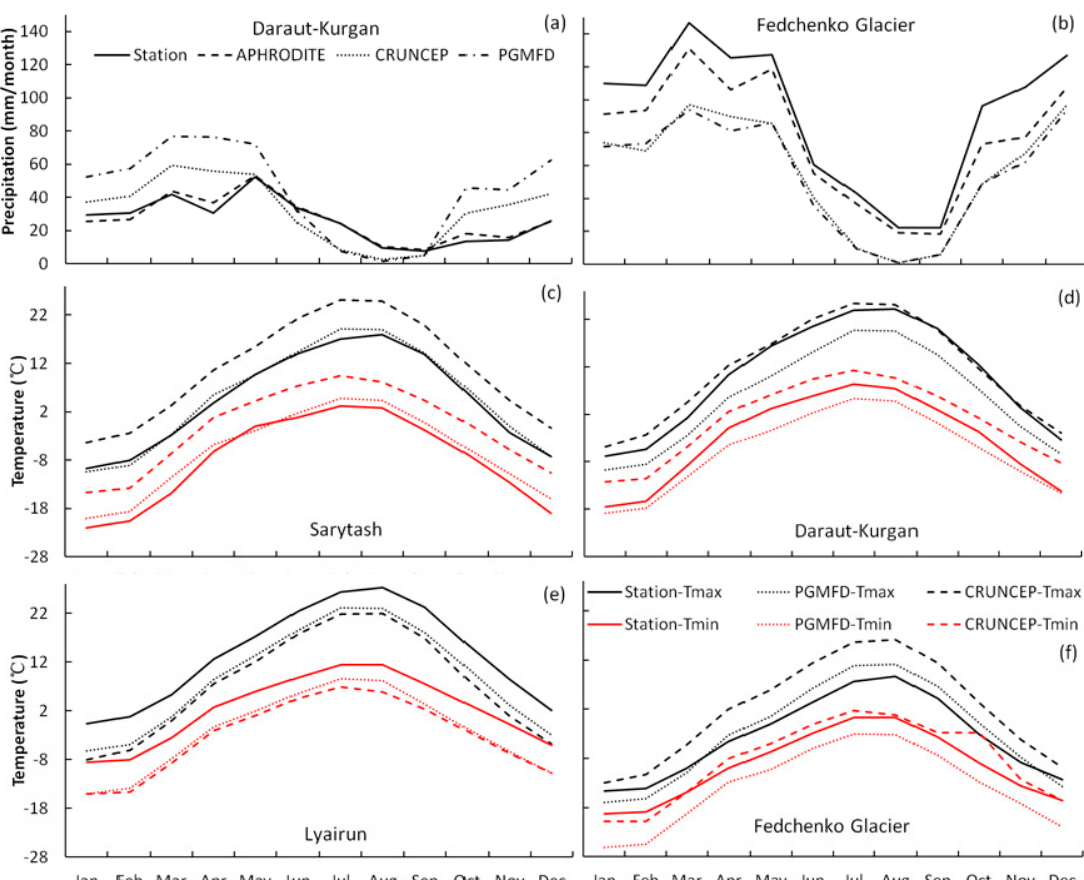
Figure 3. Annual cycles of temperature and precipitation based on the WSD and gridded data sets. ( a ) Annual cycle of precipitation at Daraut ‐ Kurgan station; ( b ) Annual cycle of precipitation at Fedchenko Glacier station; ( c ) Annual cycles of maximum (Tmax) and minimum (Tmin) temperature at Sarytash station; ( d ) Annual cycles of Tmax and Tmin at Daraut ‐ Kurgan station; ( e ) Annual cycles of Tmax and Tmin at Lyairun station; ( f ) Annual cycles of Tmax and Tmin at Fedchenko Glacier station.